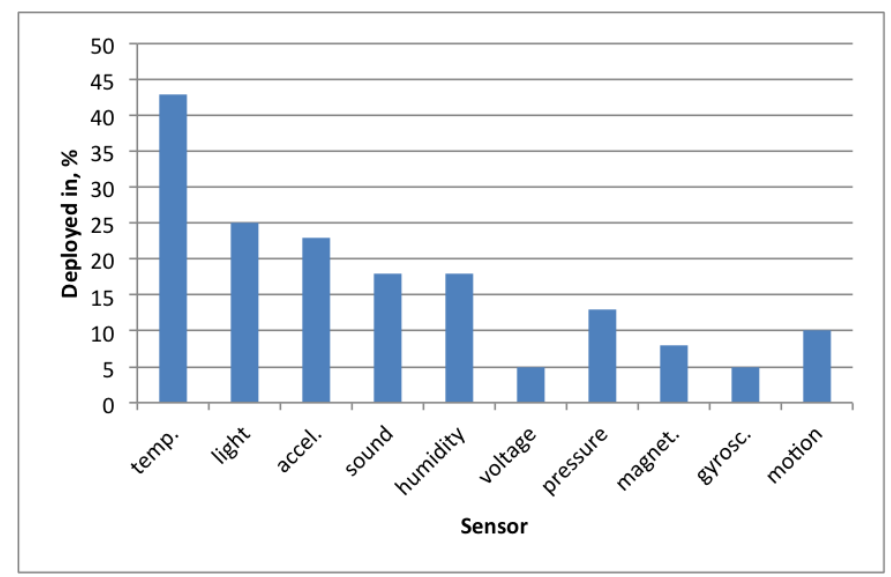
Figure 3. Sensors used in deployments —Temperature, light and acceleration sensors are the most popular: each of them used in more than 20% of analyzed